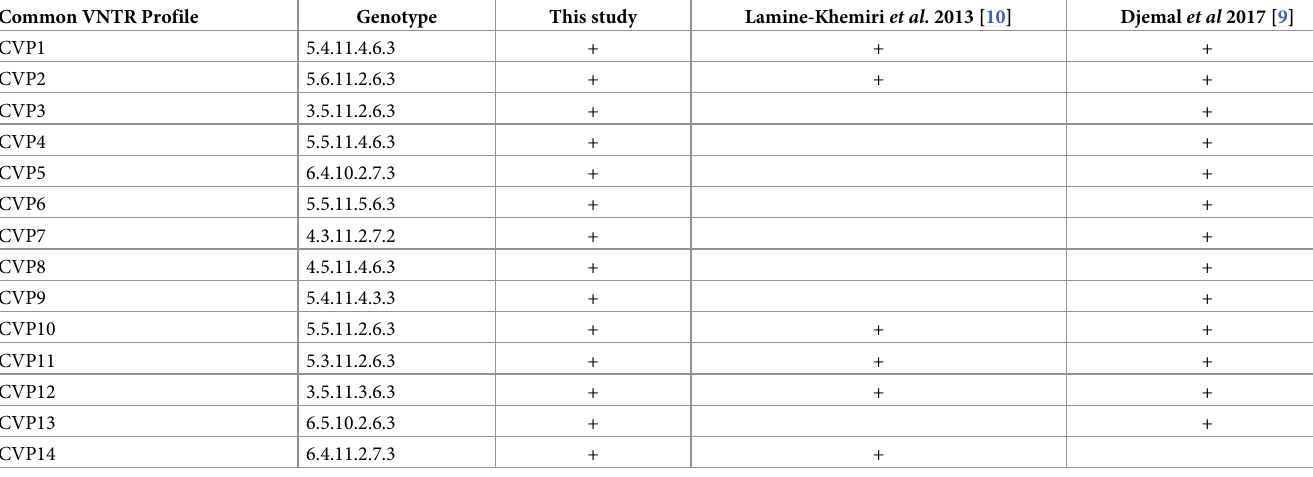
Table 5. Comparison of the distribution of common VNTR profiles between our study and previous studies in cattle in Tunisia [9, 10]. Common VNTR